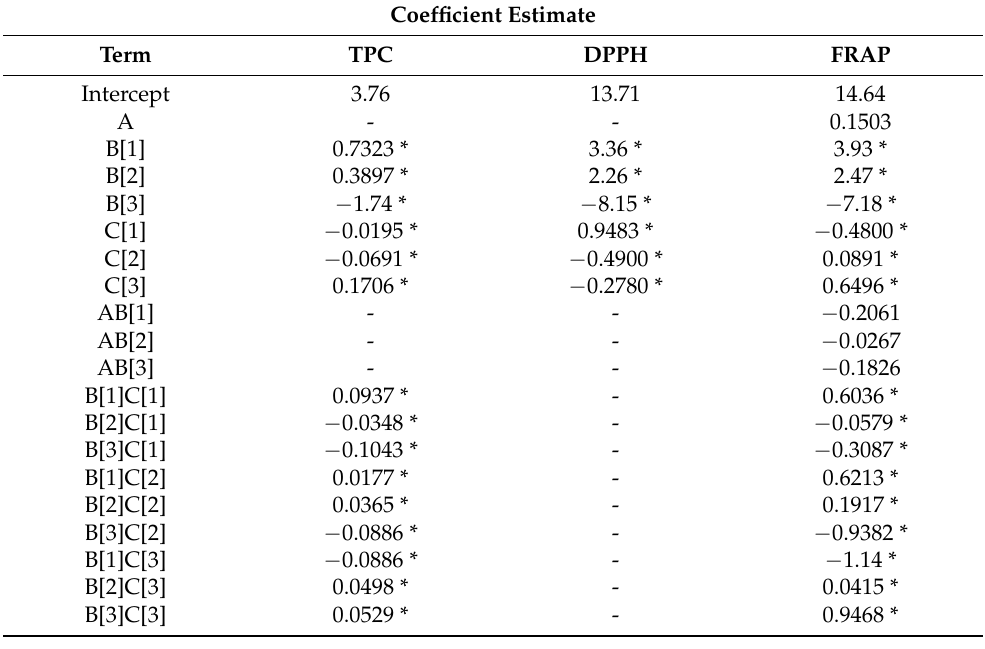
Table 4. Summary of regression coefficients. A[ n ] = pulverisation; B[ n ] = solvent type; C[ n ] = extrac- tion process; AB[ n ] = interaction of pulverisation and solvent, B[ n ]C[ n ] = interaction of solvent type and extraction process. * = significant p -value < 0.05.